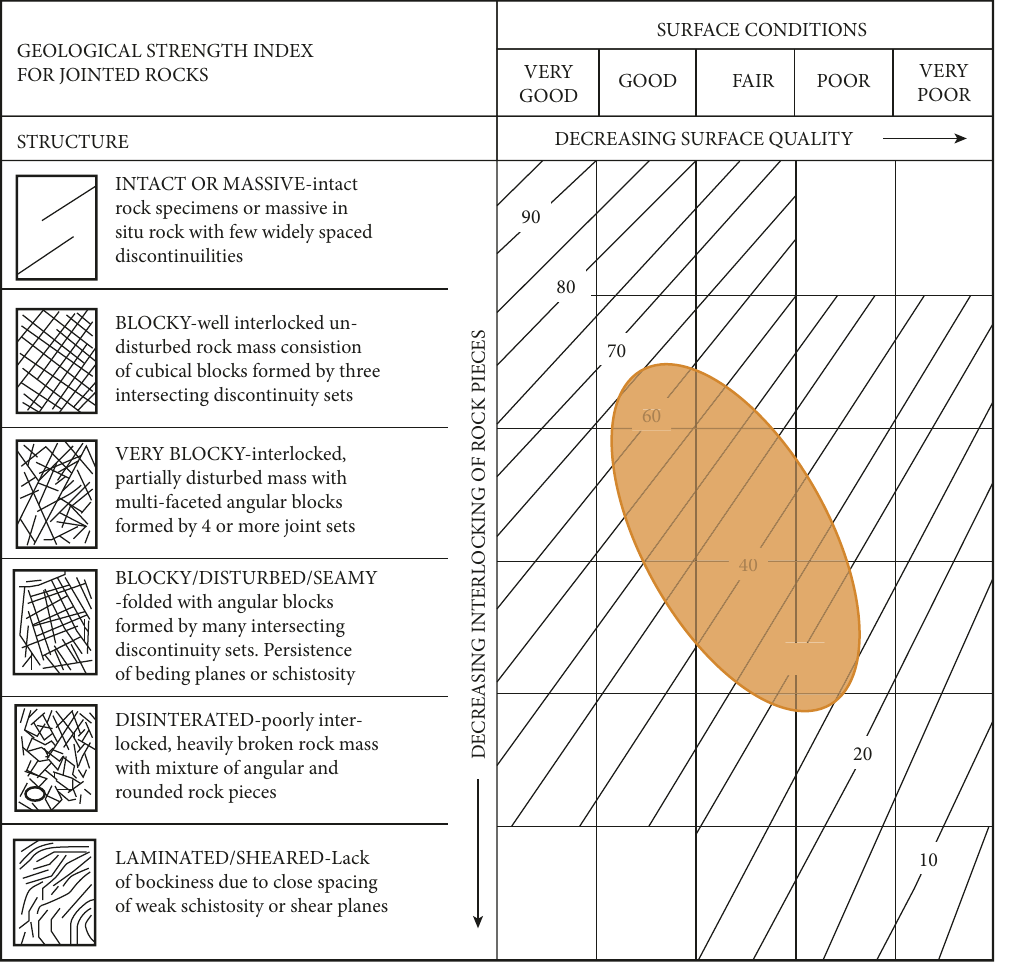
Figure 11: Chart showing GSI values of Roudbar quadrangle [49].